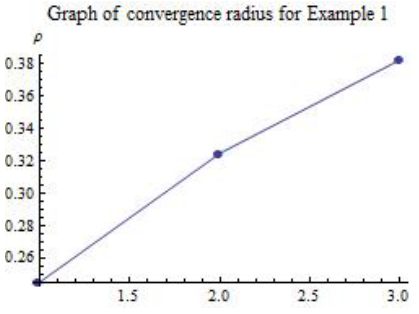
Figure 1. Convergence radius for different cases of κ ( u )